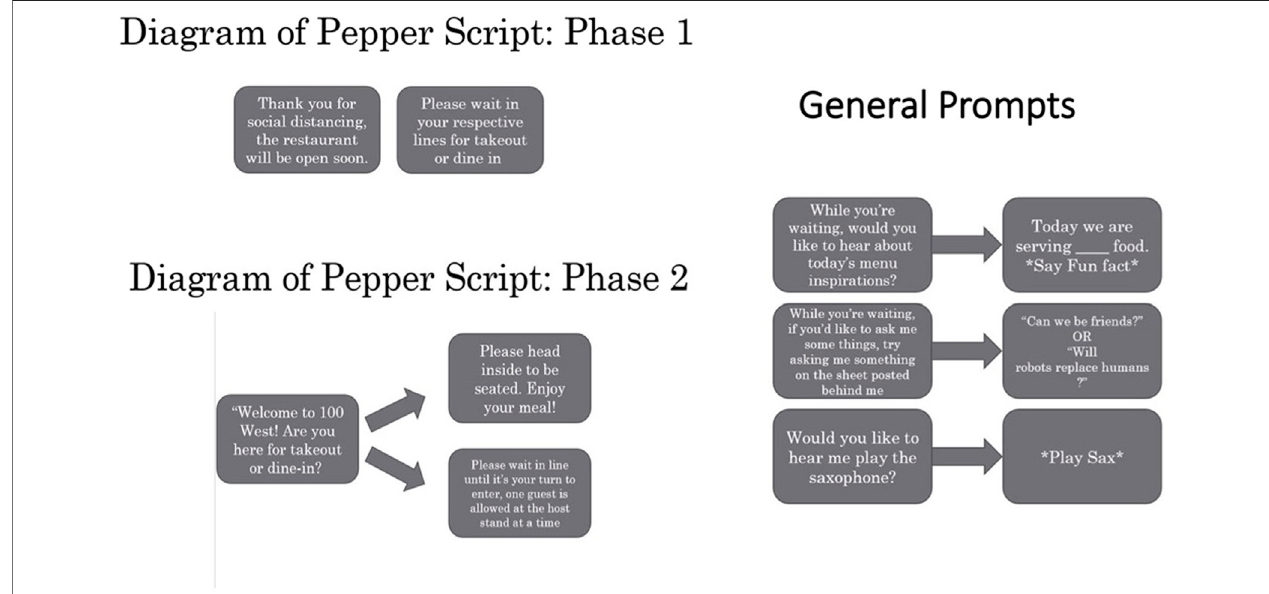
FIGURE 6 | A depiction of all possible interactions with Pepper. Phase one and phase two scripts occurred in the fi rst half and last half of days of data collection, respectively. General prompts occurred across phase one and phase two.